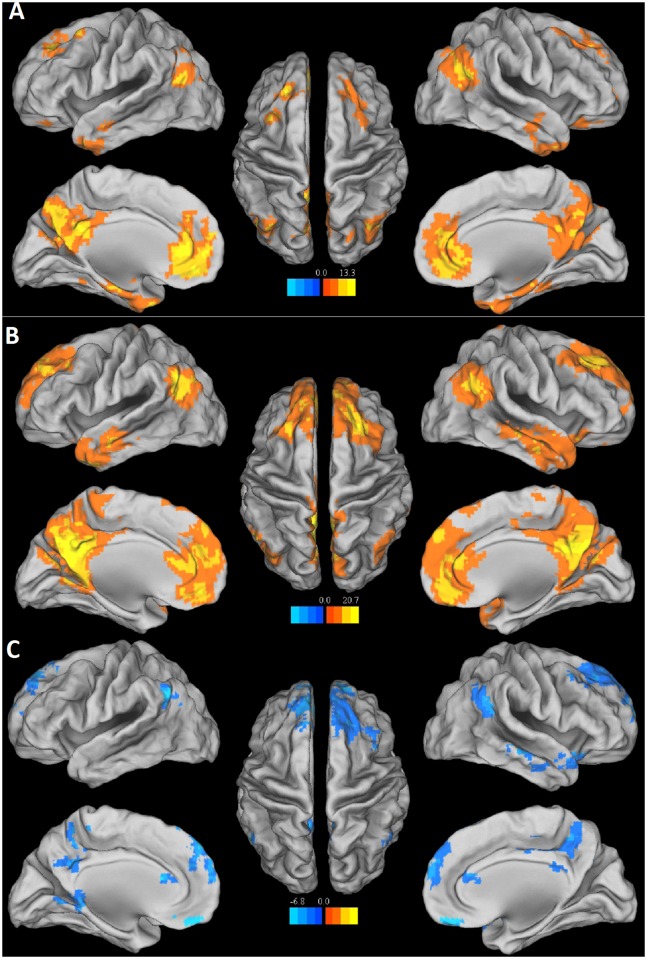
Group-level analyses of the DMN.A: DMN in the HDI (T> 3.16, P < 0.01, FDR corrected). B: DMN in the Control (T>4.23, P < 0.01, FDR corrected). C: Contrast between the DMN in HDI and controls (| T | >2.7, P < 0.05, FDR corrected). T values, cluster size, and Talairach coordinates of all significant clusters are reported in Table 2.